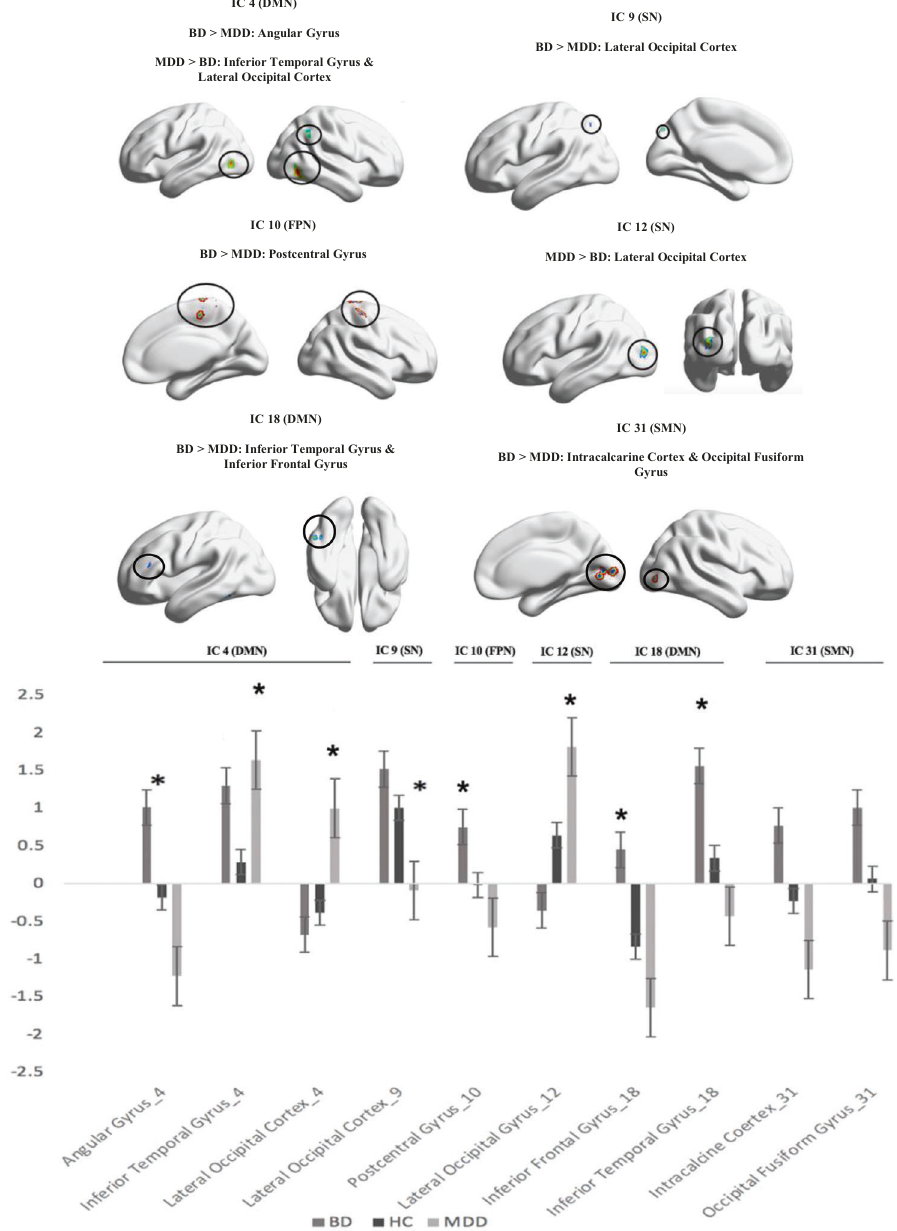
Fig. 3 ICs with signi fi cantly different connectivity pro fi les between BD and MDD. The BD group exhibited greater connectivity than MDD in the following components: 1. IC 4 (DMN) with the angular gyrus, 2. IC 9 (SN) with the lateral occipital cortex, 3. IC 10 (FPN) with the postcentral gyrus, 4.. IC 18 (DMN) with the inferior temporal gyrus and inferior frontal gyrus and 5. IC 31 (Sensorimotor Network) with the intracalcarine cortex and occipital fusiform gyrus. On the other hand, MDD exhibited greater connectivity than BD in the following components: 1. IC 4 (DMN) with, lateral occipital cortex and inferior temporal gyrus and 2. IC 12 (SN) with the lateral occipital cortex. * p < inferior frontal gyrus is related to cognitive/emotional control DLPFC in both MDD and BD have been associated with and in past literature has been found to be underactive in both improvement in depressive and cognitive symptoms [30, 31]. symptomatic and euthymic BD patients relative to HC and has Research has shown that the mechanism for rTMS treatment is via been associated as a trait mechanism in at-risk cohorts [34, 35]. the connectivity of the DLPFC to the sgACC [31]. Importantly, rTMS Connectivity from the DMN to the inferior frontal gyrus may targeting the DLPFC in BD was found to alleviate both depressive indicate disrupted functioning of the FPN which could relate to and manic symptoms, which may suggest a differential role of this the dif fi culties observed in appraising and subsequently connectivity feature between BD and MDD [32, 33]. regulating emotionally signi fi cant stimuli. This region has also The fi rst notable fi nding from the ICA analyses, which is been reported as an endophenotype of BD [34]. Its role in BD is similar to the seed-based analysis fi nding, is the greater also supported in our work as the signi fi cant difference in DMN- connectivity between the DMN and inferior frontal gyrus inferior frontal gyrus connectivity was present for BD vs HC and (DLPFC), an FPN node in BD, relative to MDD and HC. The